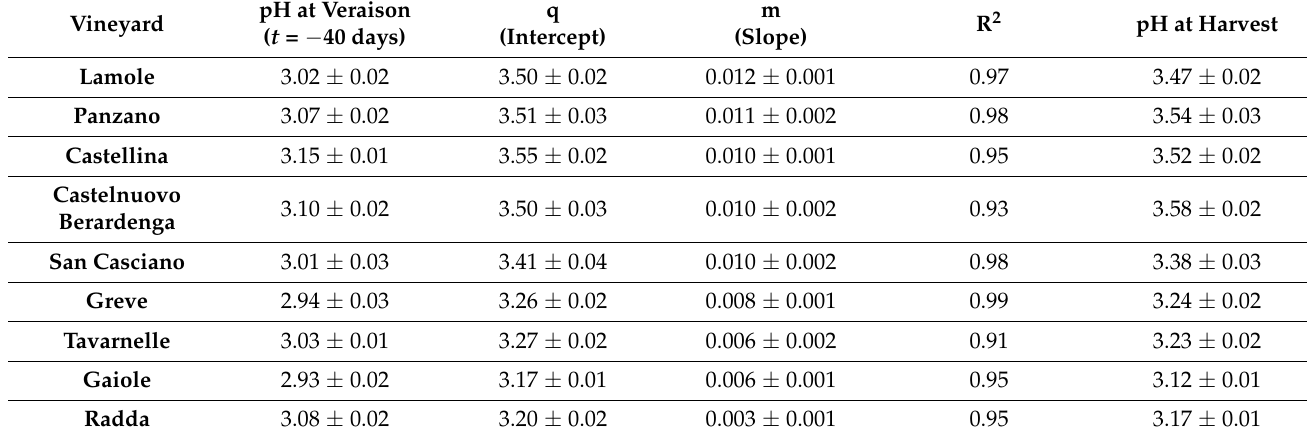
Table 8. Calculated values of the functional parameters, intercept, slope and R 2 of the pH inside the grapes coming from the different vineyards.